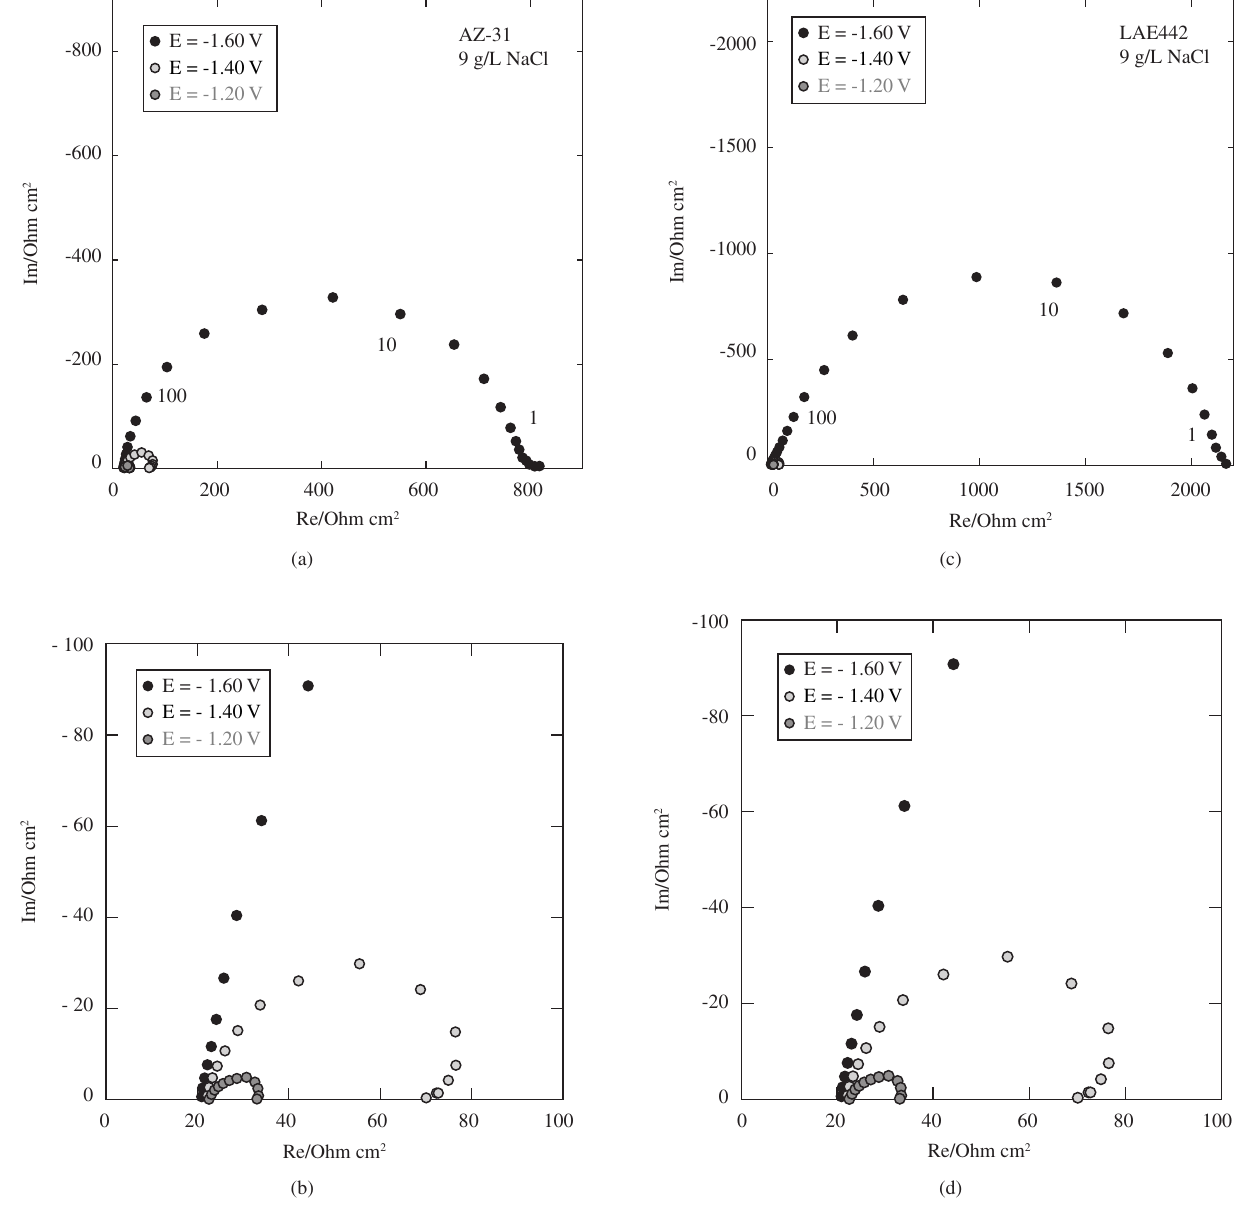
Figure 8. Impedance diagrams of magnesium alloys in 9 g/L NaCl solution at different operational potentials (-1.6 V, -1.4 V, -1.2 V). a) AZ31 alloy; b) Detail at higher magnification; c) LAE442 alloy; and d) Detail at higher